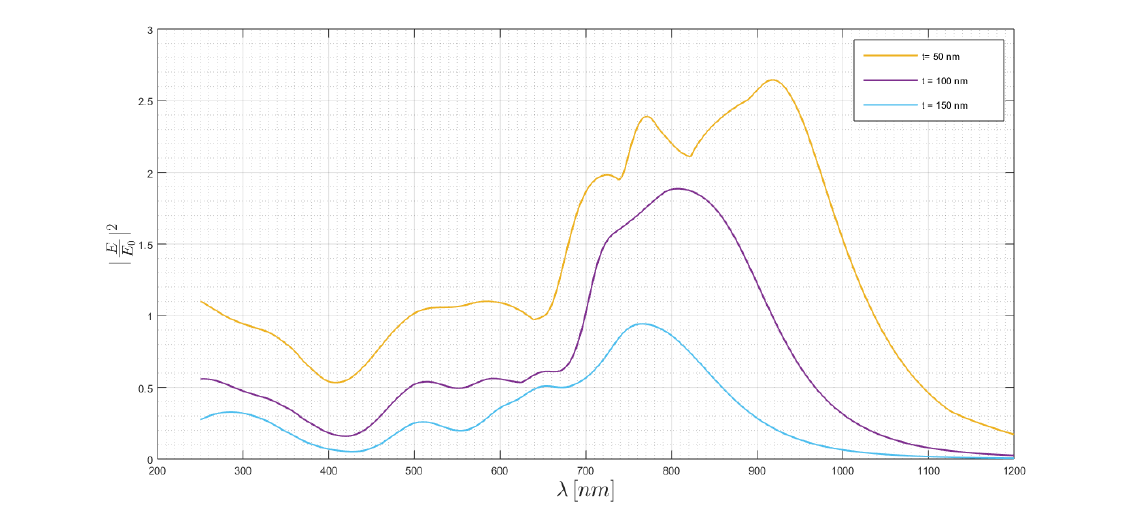
Figure 11. Nanoantenna thickness sweep on the silver